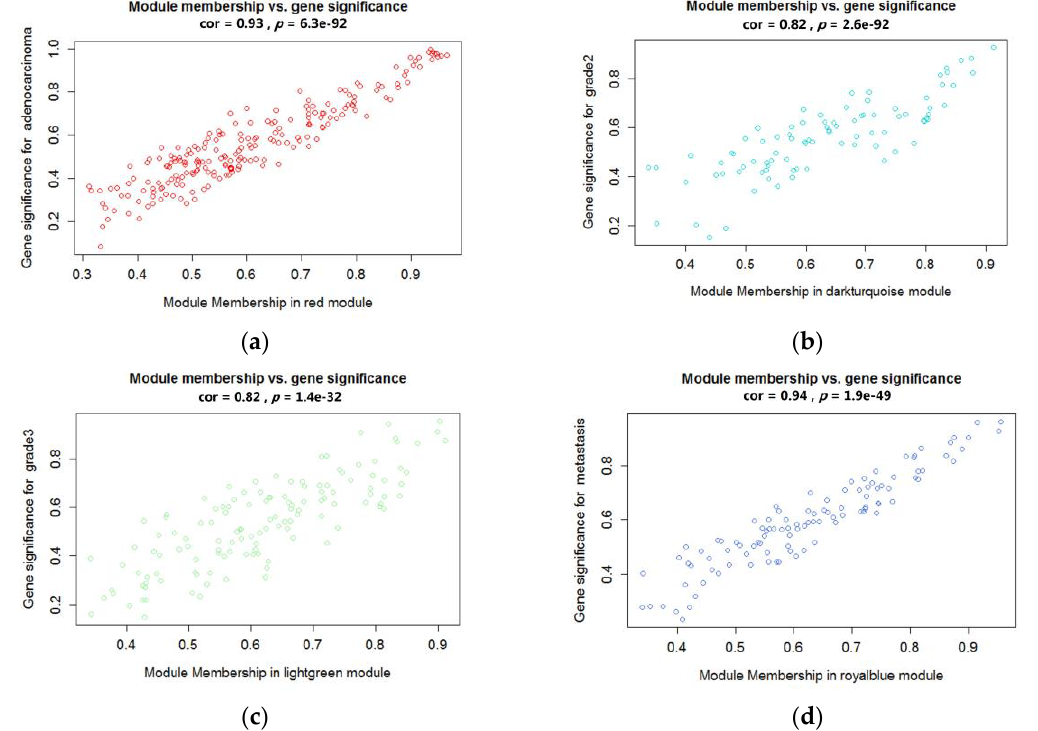
Figure 5. Scatter plots of the highly correlated module in different clinical subtypes of bladder cancer. ( a ) Red module was found to have the highest association with human adenocarcinoma lymph node metastasis; ( b ) Darkturquioise module was found to have the highest association with Grade 2 carcinoma; ( c ) Lightgreen module was found to have the highest association with Grade 3 carcinoma; ( d ) Royalblue module was found to have the highest association with transitional cell carcinoma lymphatic metastasis.